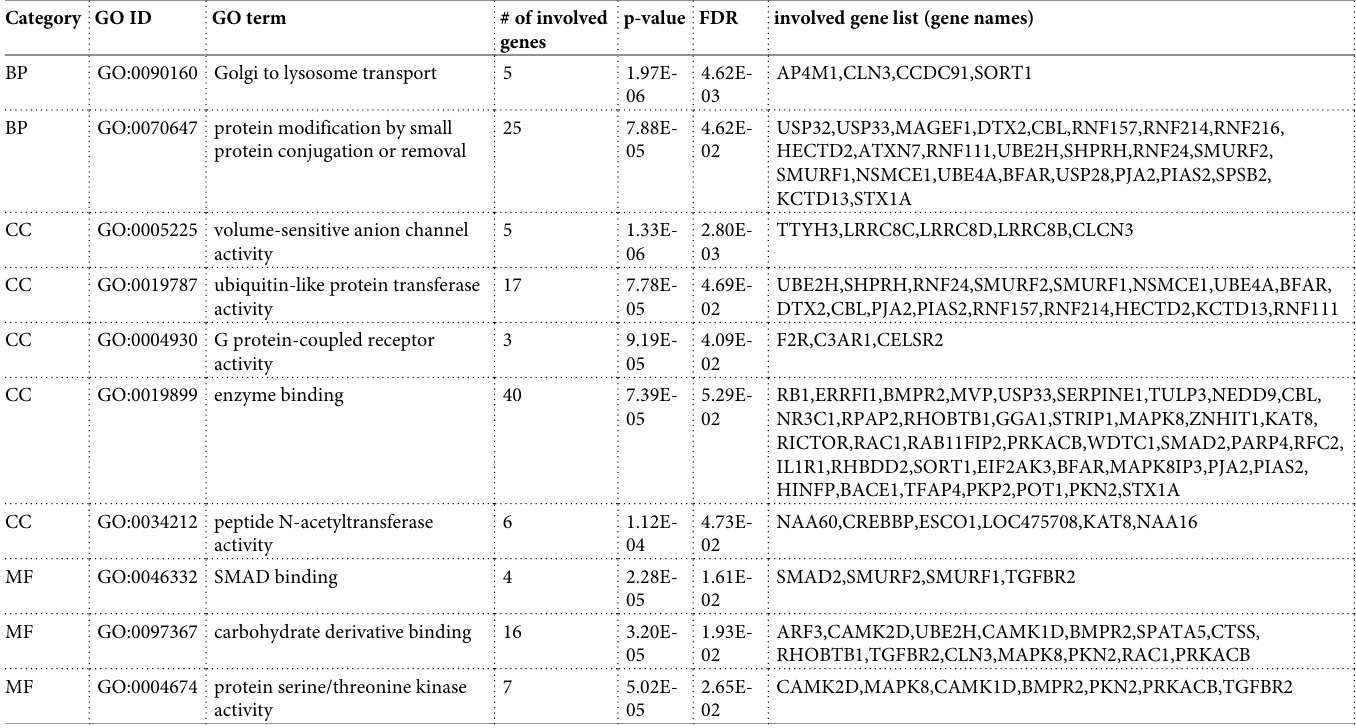
Table 1. Significantly enriched GO terms in hypermethylated/upregulated genes in gene-body regions in CLBL-1 8.0.